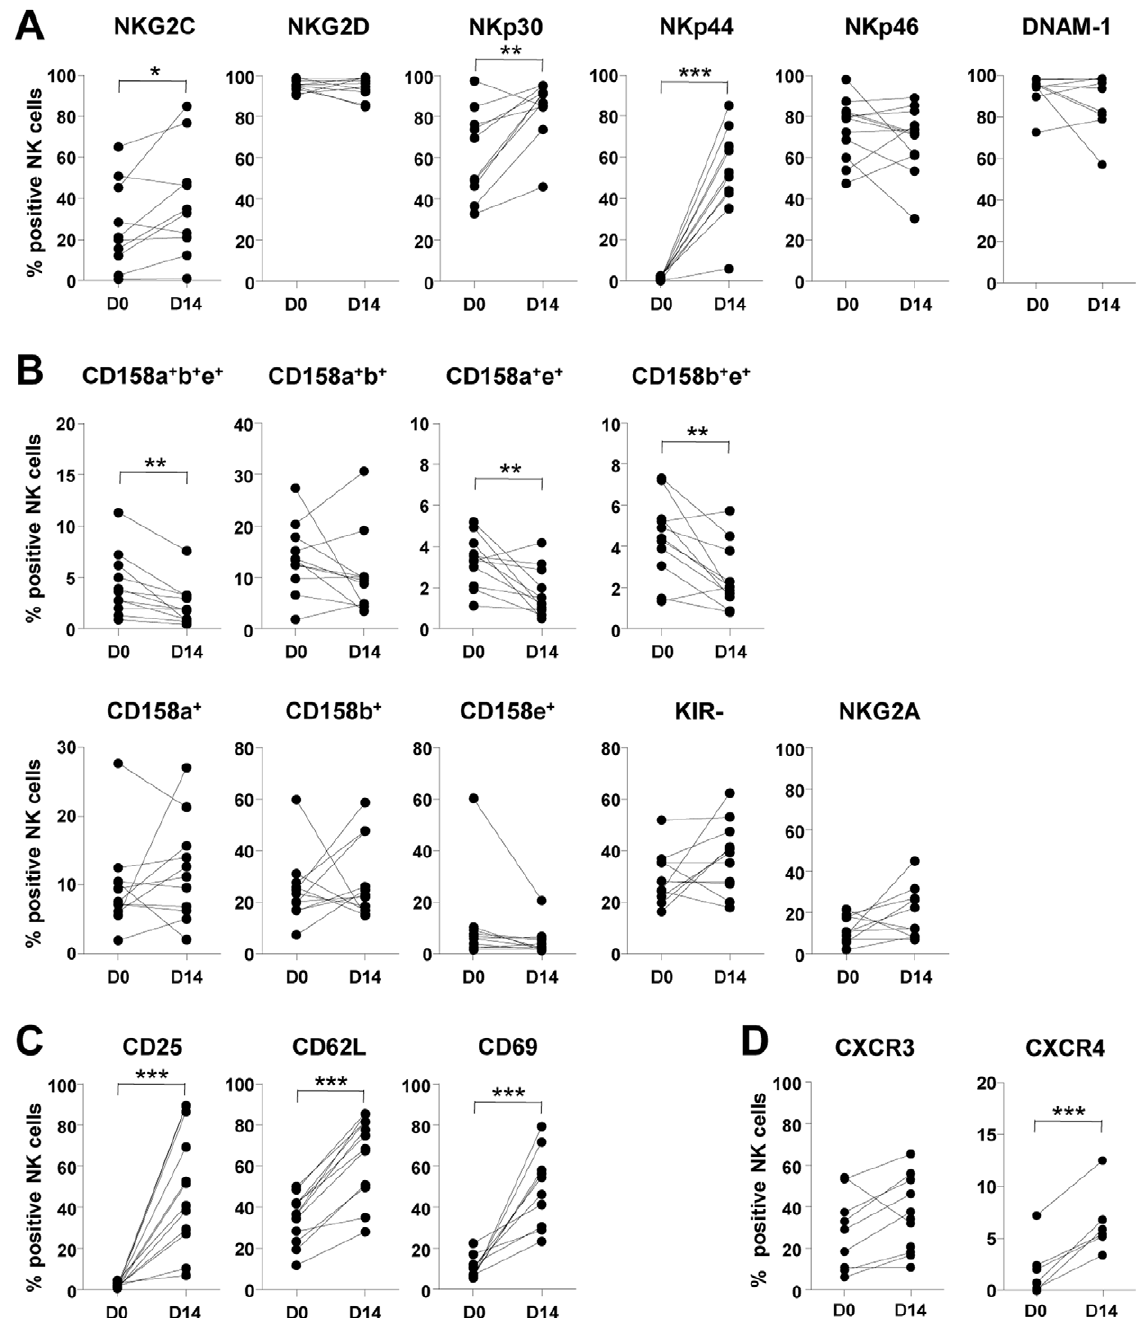
Figure 2. Phenotypic comparisons of resting and expanded NK cells. Surface expression of activating receptors (A), inhibitory receptors (B), activation markers (C) and chemokine receptors (D) was analyzed by flow cytometry before (D0) and after (D14) NK cell expansion (n=10 , 12). Individual or coexpression of KIRs (CD158a, CD158b or CD158e) was calculated by Boolean gates using FlowJo software (B). * p , 0.05; ** p , 0.01; *** p , 0.001.